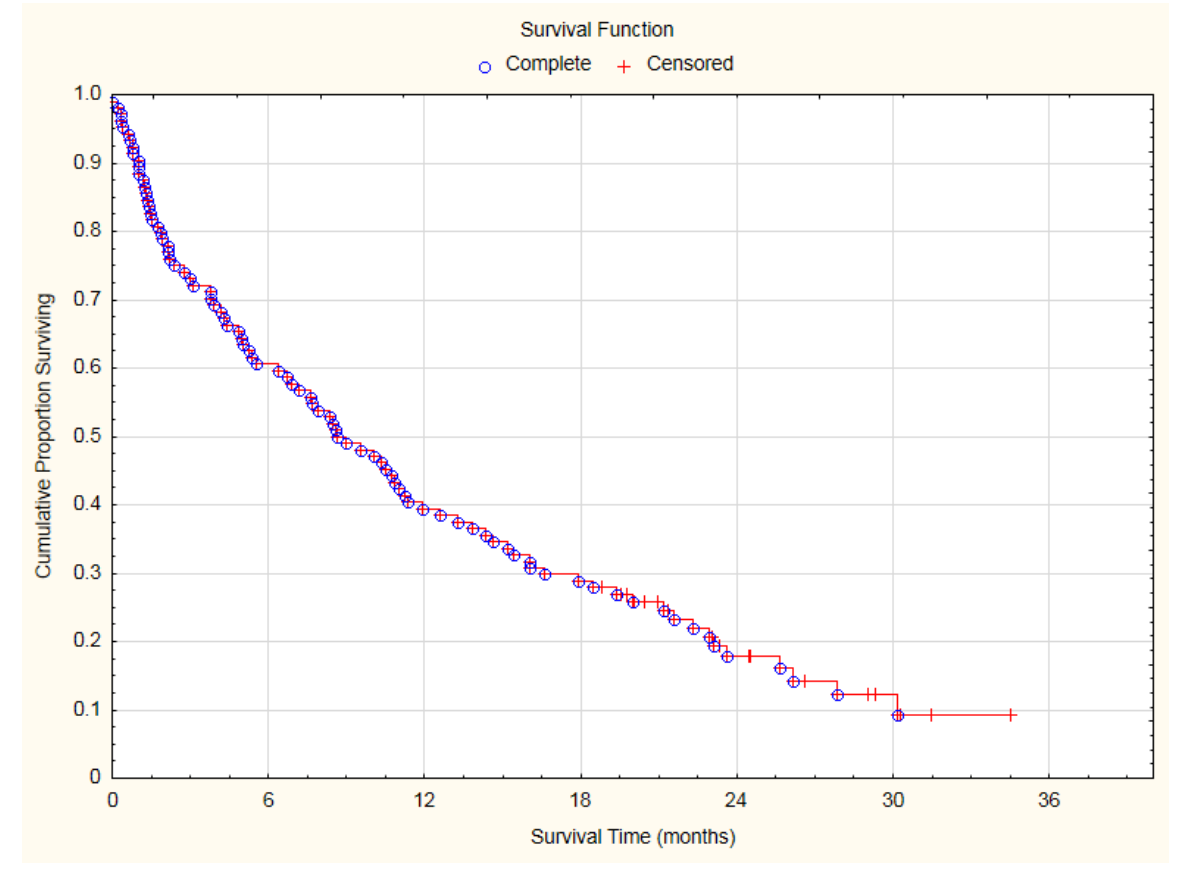
Figure 1. Overall survival curve of analyzed lung cancer patients. Table 2. Cardiovascular toxicities of lung cancer therapies diagnosed in accordance with the Interna- tional Cardio-Oncology Society 2021 consensus statement